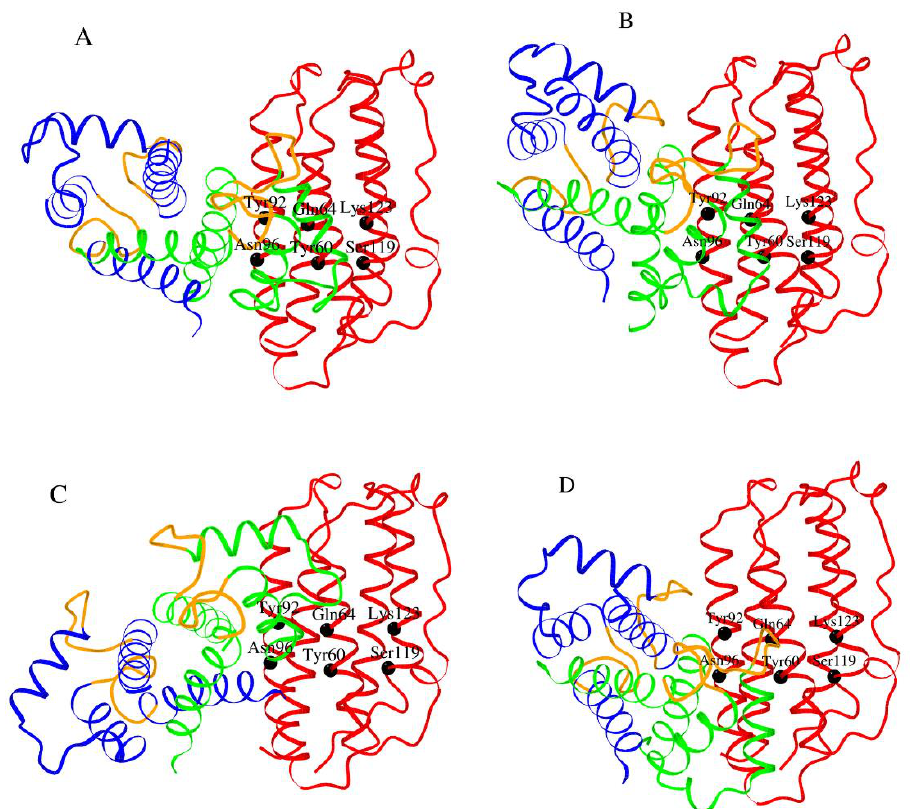
Figure 9. The models of tertiary structures of Ca 2 + -loaded human S100P (panel A ), S100A1 ( B ), S100A4 ( C ) and S100A6 ( D ) dimers (the monomers are shown in blue / green) bound to a molecule of human IFN- β (red) built using GRAMM-X protein–protein docking software v.1.2.0 [58]. The Ca 2 + -binding loops are shown in orange. The contact residues of IFN- β are labelled.